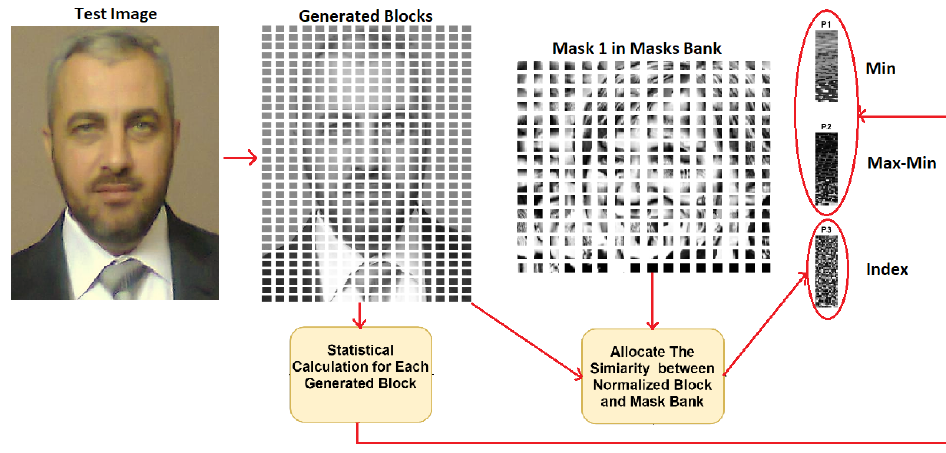
Figure 7. An example of the processes of parameter generation in the first iteration.